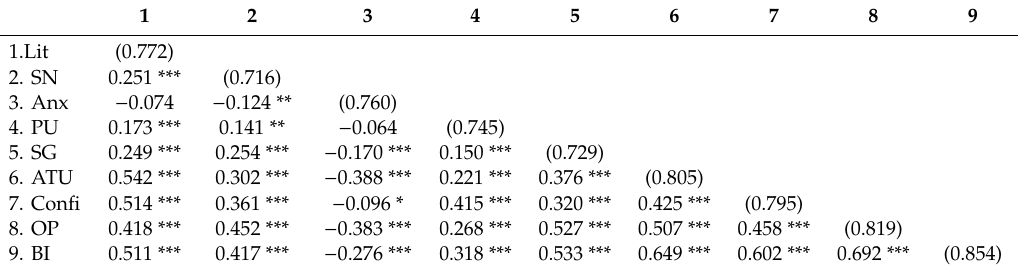
Table 2. Discriminant validity of